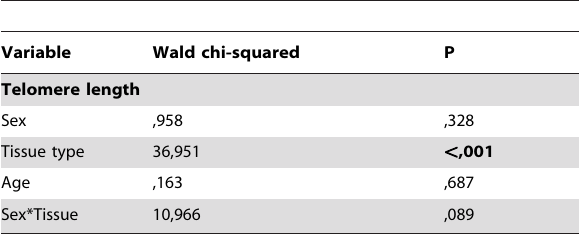
Table 1. Determinants of telomere length evaluated in different tissues of adult zebra finches (GEE analysis).